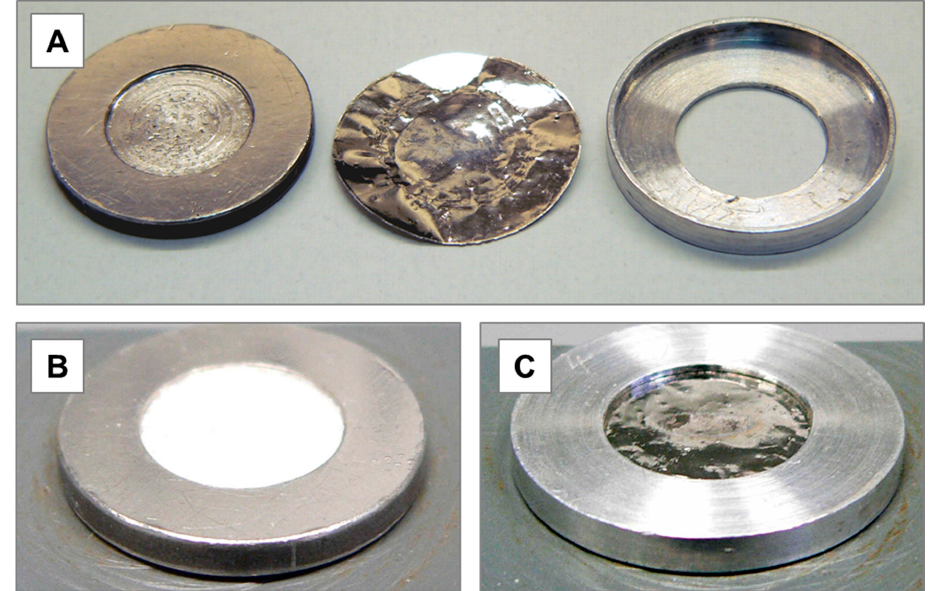
Figure 9. ( A ) Pt-target disk, Pt-foil, and Al-holder for the irradiation; ( B ) open nat CsCl target after pressing and before closing with Pt foil; ( C ) complete target after 4 h of